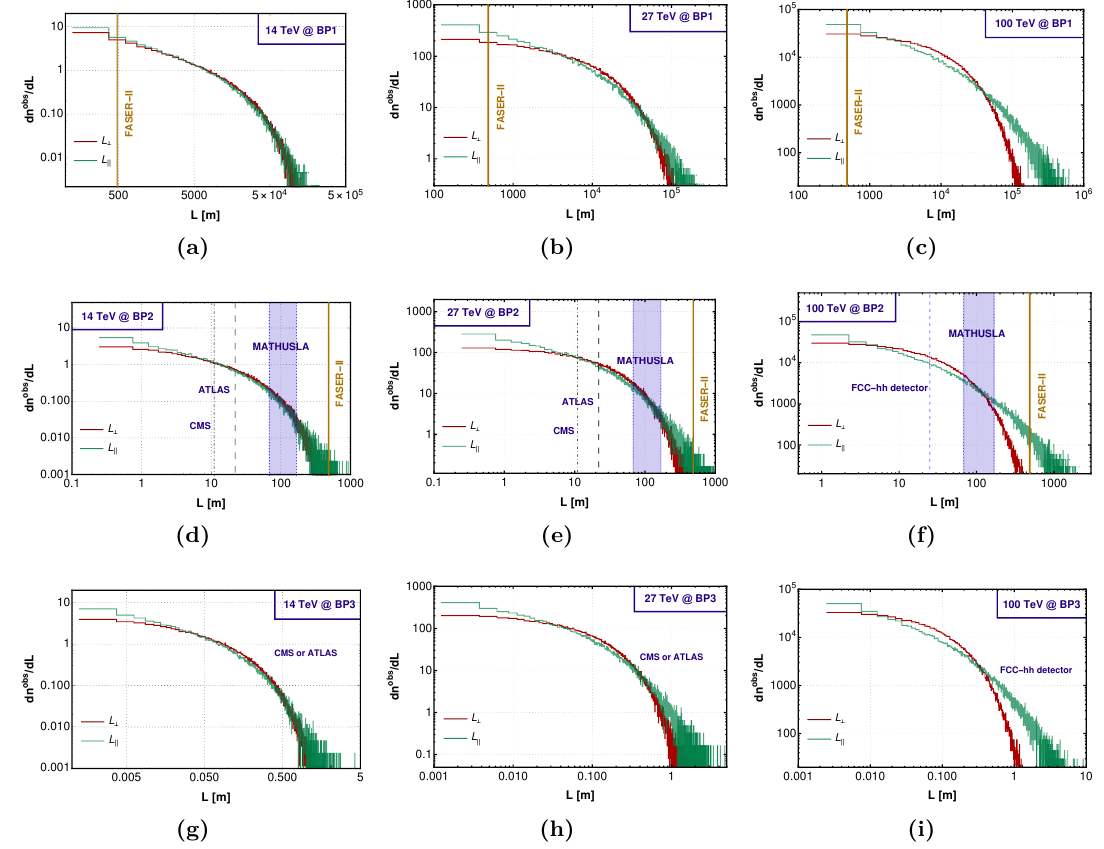
in green) decay length distri- Figure 9. Displaced transverse ( L ⊥ in red) and longitudinal ( L || butions for N , coming from the pair productions at the LHC with the centre of mass energies of 14 TeV (a, d, g), 27 TeV (b, e, h) and 100 TeV (c, f, i) for the integrated luminosities of 3, 10 and 30 ab − 1 , respectively. The first, second and third rows delineate the distributions for BP1, BP2 and BP3, respectively. The black dotted-dashed and dashed lines indicate the upper limit of CMS and ATLAS, respectively, whereas, the blue dashed line specify the upper limit of the proposed FCC-hh detector. The light blue band (68 m − 168 m) denotes the MATHUSLA region and the golden yellow strip denotes the FASER-II region. All of the regions depicted here are in the longitudinal